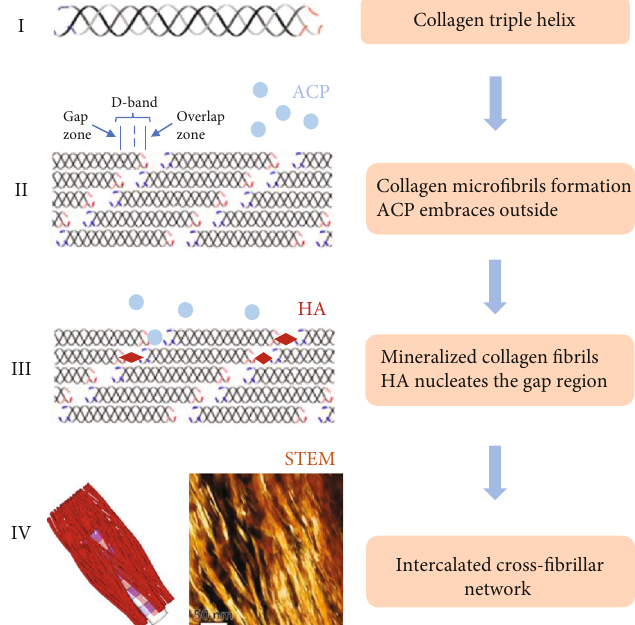
Figure 3: The quaternary hierarchical architecture of collagen and mineral assembly. The fi rst structure is collagen molecules with the triple helix [15]. Secondly, collagen molecules form micro fi brils with D -bands, and ACP embraces outside of micro fi brils [54, 55]. Then, HA crystals nucleate the gap regions within mineralized collagen fi brils [55]. Finally, mineralized collagen fi bers with mineral crystals create an intercalated cross- fi brillar network